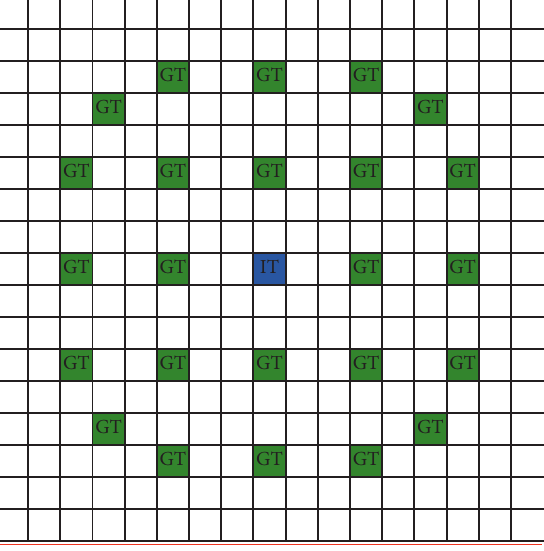
Figure 1: Locations of fuel rods, guide thimbles (GT), and in- strumentation thimble (IT) in a fuel